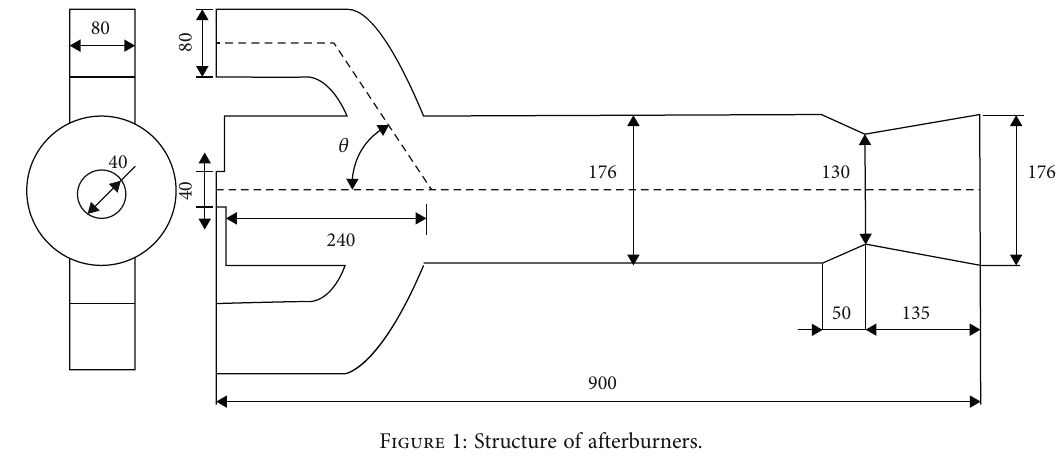
Figure 1: Structure of